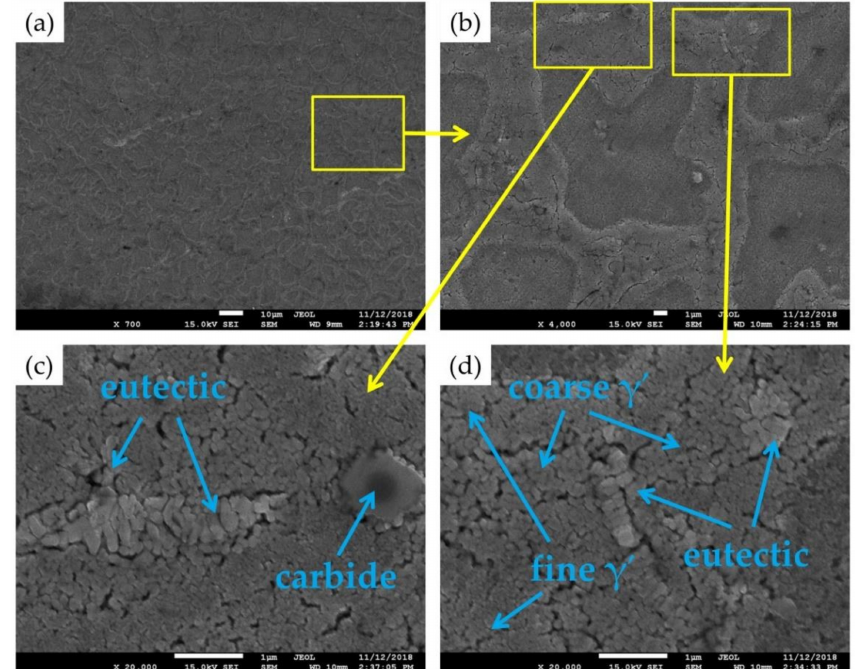
Figure 14. Typical microstructure on the X–Z section of the as-remelted LFRed K417G.